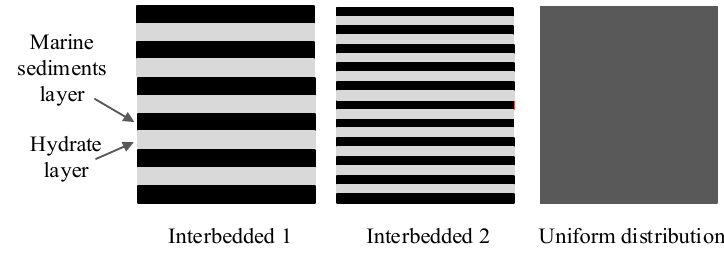
Figure 4. Schematic diagrams of HBMS with different forms of hydrate.